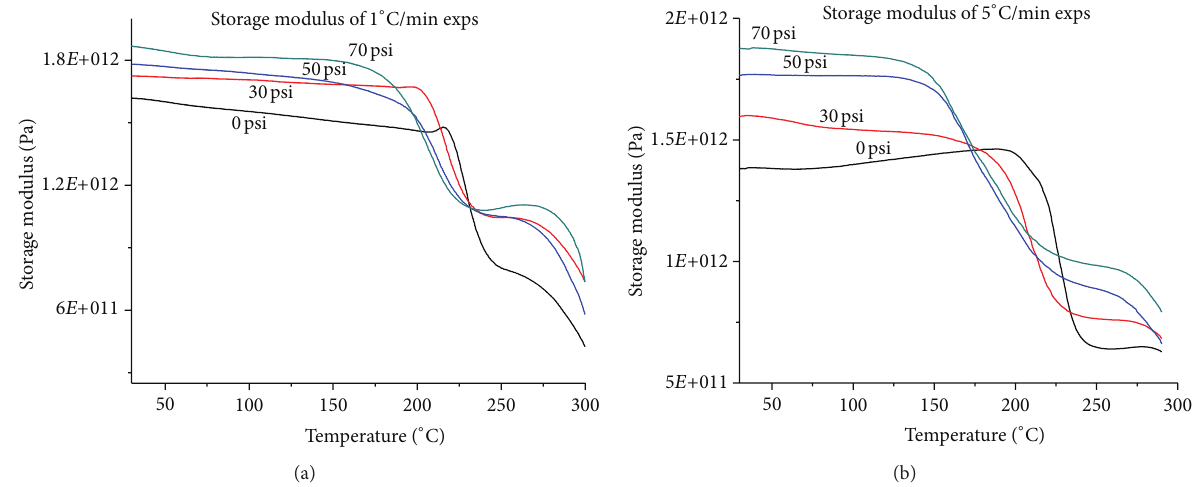
Figure 11: Storage modulus of carbon fiber prepregs—8 plies manufactured at 0, 30, 50, and 70psi in 1 and 5 ∘ C /min.